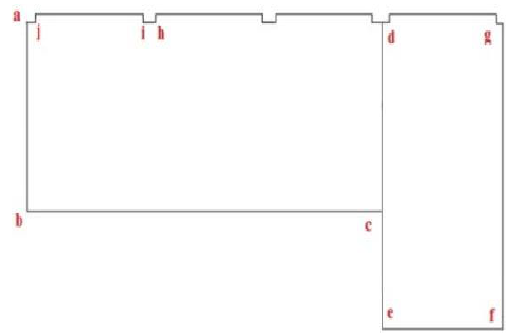
Figure 18. Point of distance measurement that been referred.